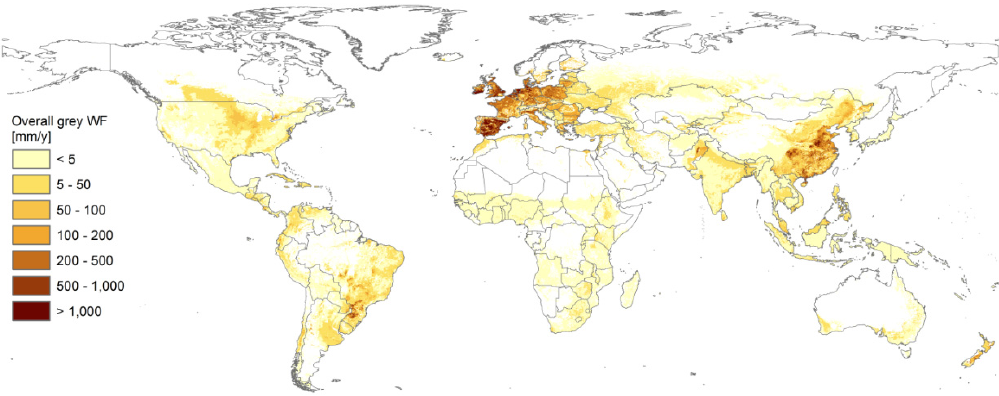
Figure 3. The global GWF of the EU-27 related to consumption of agricultural products shown in mm/year on a 5 by 5 arc-min grid. Data per grid cell have been calculated as the WF within a grid cell (in cubic meters per year) divided by the area of the grid cell (in 10 3 m 2 ). Period: 2007. Water 2016 , 8 , 30